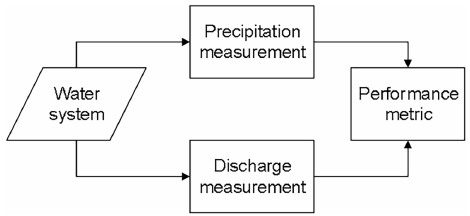
Figure 3. General procedure for model-free sensor network evalua- tion.